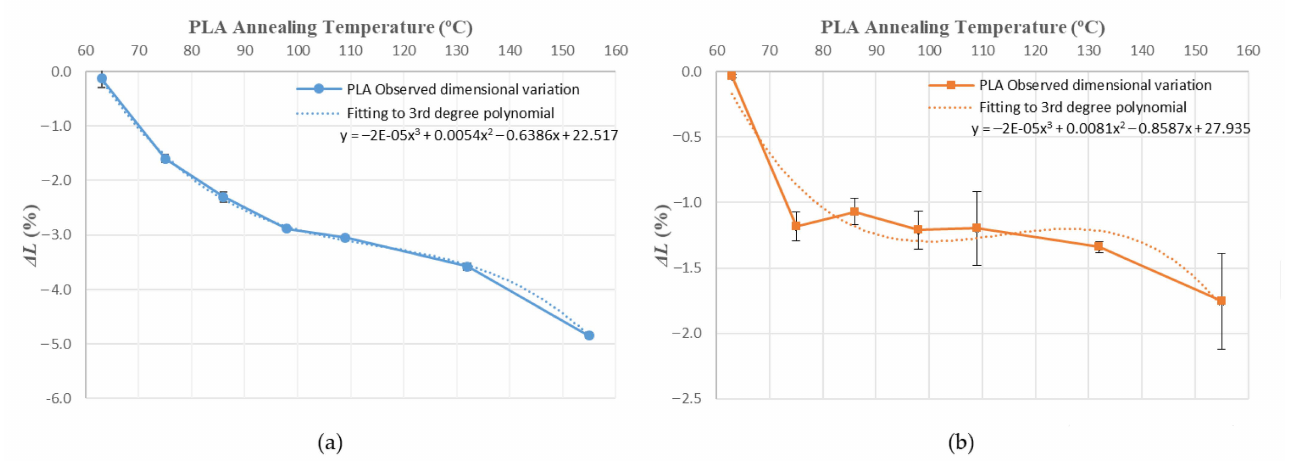
Figure 10. ABS Length variation vs. annealing temperature third-degree polynomial approximation: ( a ) without mould; ( b ) with mould.